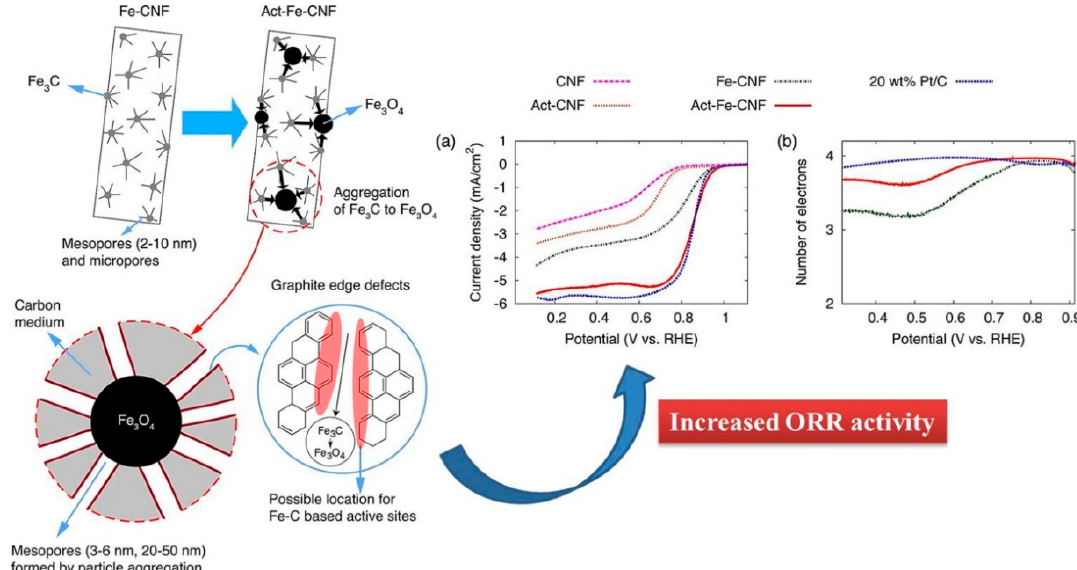
Figure 8. Schematic of the development of hierarchical meso/macropore structure and graphite edge defects where the potential ORR active sites are formed by water vapor activation. Image ( a ) shows the I-V curve of glassy carbon RDEs modified with metal-free CNF, vapor-activated metal-free CNF